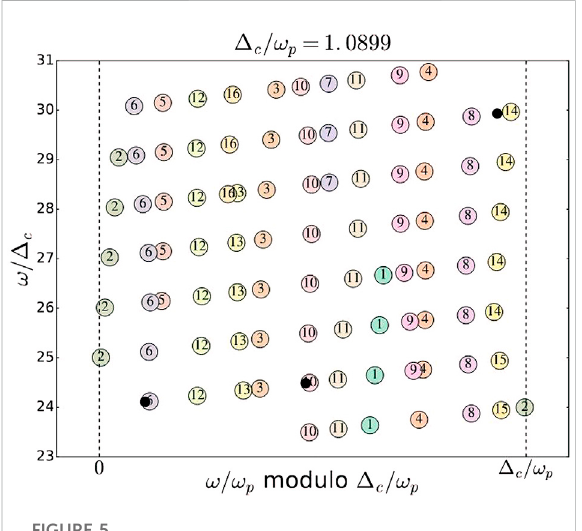
FIGURE 5 Échelle diagram showing all chaotic modes in a polytrope in the high-frequency range — the frequency unit ω p is computed from the keplerian velocity computed using the polar radius – . Series of similar modes are labelled 1 to 16, while black dots are modes that do not belong to any series. Figure taken from Evano et al.